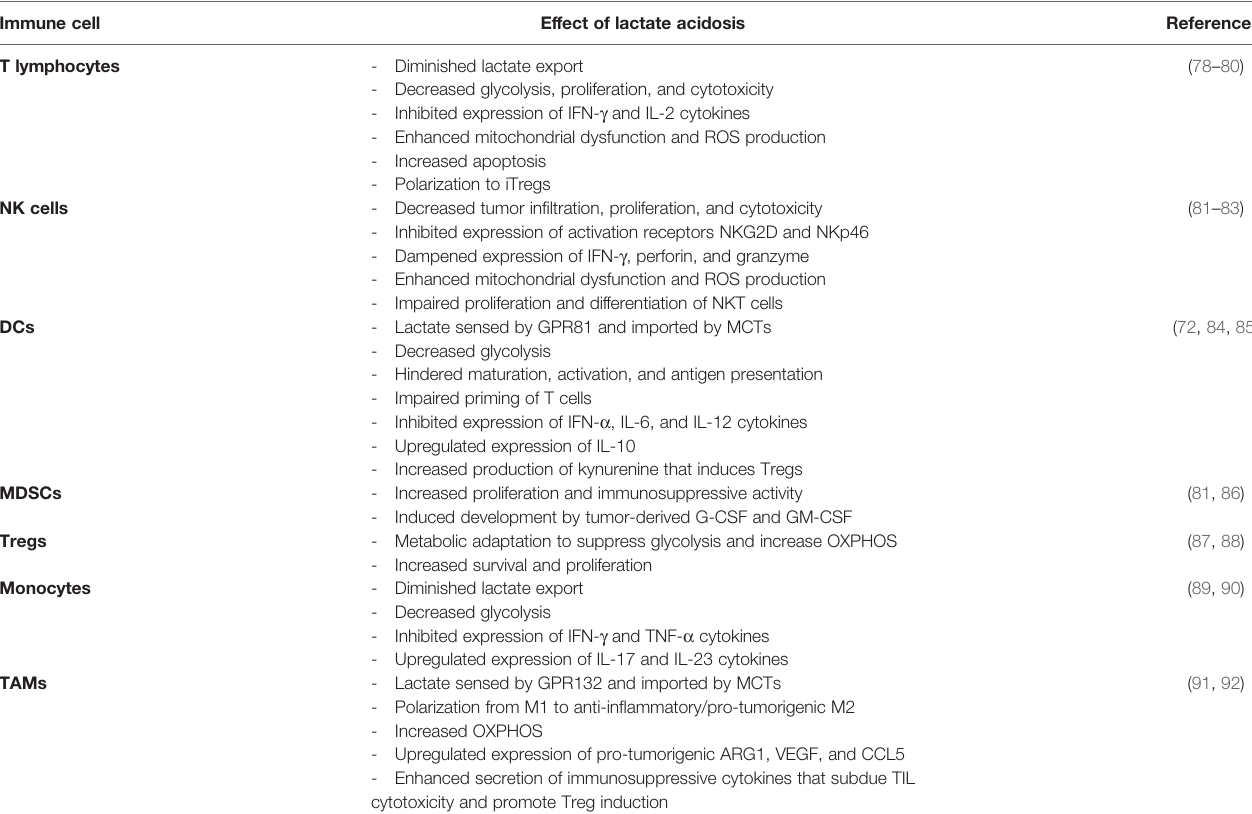
TABLE 1 | Impact of lactate acidosis on immune cells in the tumor microenvironment. Immune